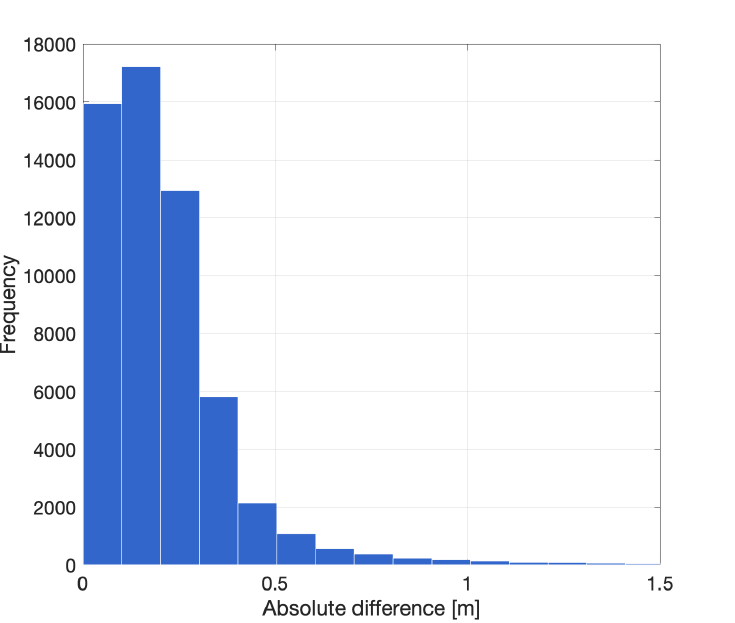
Figure 11. Histogram showing the absolute differences between ICESat-2 and EOMAP depth estimates for Heron Reef,